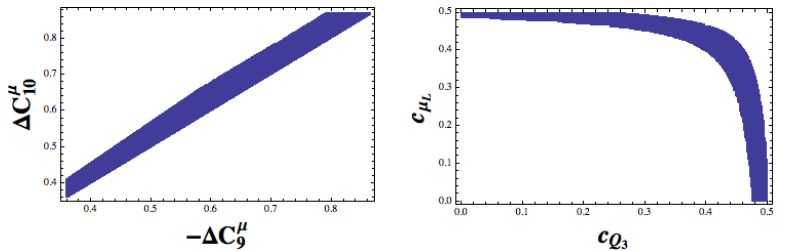
Figure 2. Scenario B : Left plot gives the distribution for ∆ C 9 and ∆ C 10 . The corresponding c parameters ranges are given in the right